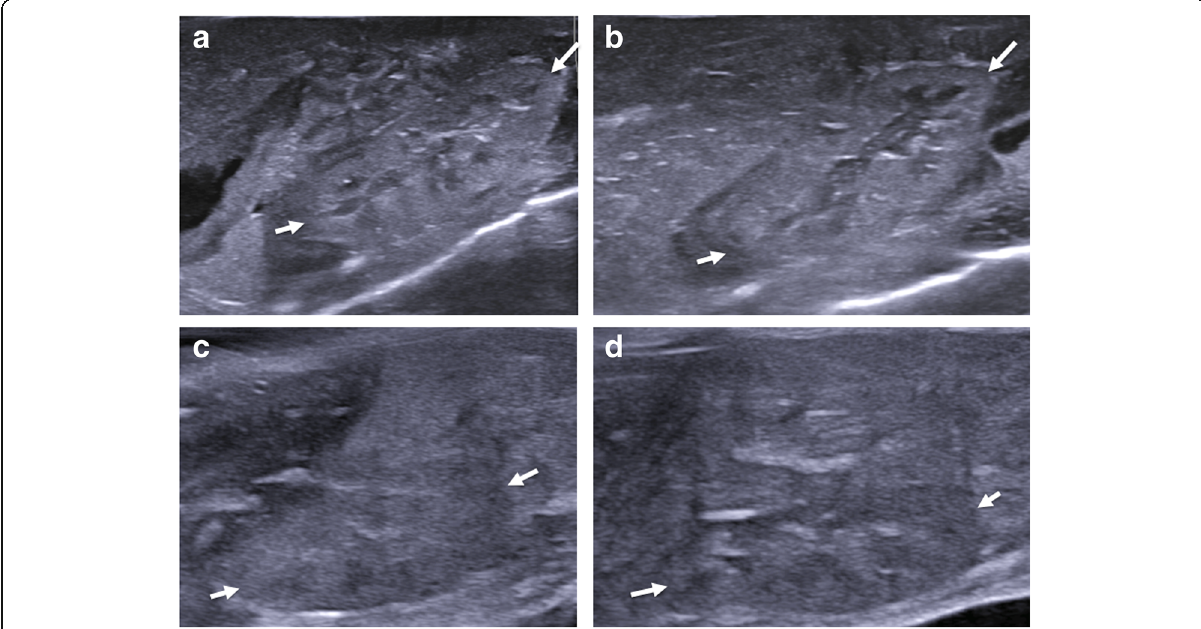
Fig. 15 Normal sagittal appearances of the kidneys at postmortem ultrasound in two different foetuses (left column ( a , c ) — left kidney, right column ( b , d ) — right kidney). The solid white arrows in each of the images demonstrate the upper and lower poles of the kidneys. Images ( a , b ) were obtained in a 20-week gestational-aged foetus, 4 days after death. They show the normal expected corticomedullary differentiation. Images ( c , d ) were obtained from a stillborn 25-week gestational-aged foetus, 10 days after death. These kidneys lack corticomedullary differentiation and are harder to identify when seen against the background of other solid abdominal viscera and bowel. All kidneys were histologically unremarkable both on antenatal ultrasound imaging and autopsy. The lack of corticomedullary differentiation is likely to relate to autolysis or maceration-related changes, rather than pathological